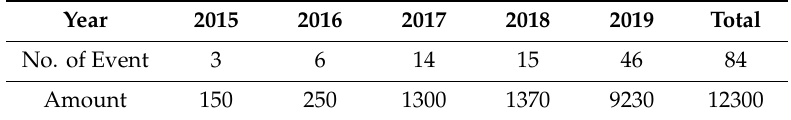
Table 3. Renewable energy curtailment in the Jeju power system from 2015 to 2019 (MWh).